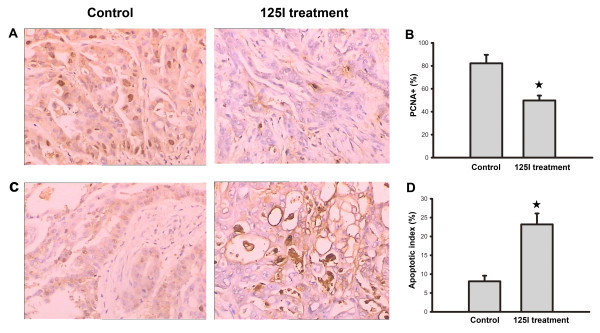
 PCNA and TUNEL analyses for tumor tissue. (A) Tumor sections immunostained with an antibody against PCNA revealed that there were many strongly positive nuclei in control tumor tissues, whereas such nuclei were rare in tumor tissues of 125I treatment group. (B) Quantification of PCNA staining showed mitotic index of 125I-implanted tumor was much lower than that of control group (☆: P < 0.05). (C) Apoptosis of tumor tissues in different groups were evaluated by TUNEL assays, which showed that 125I treatment induced a significant enhancement of apoptotic cells in contrast to control group. (D) Quantification of TUNEL assay showed that apoptosis index of 125I-implanted tumor was much higher than that of control group (☆: P < 0.05).